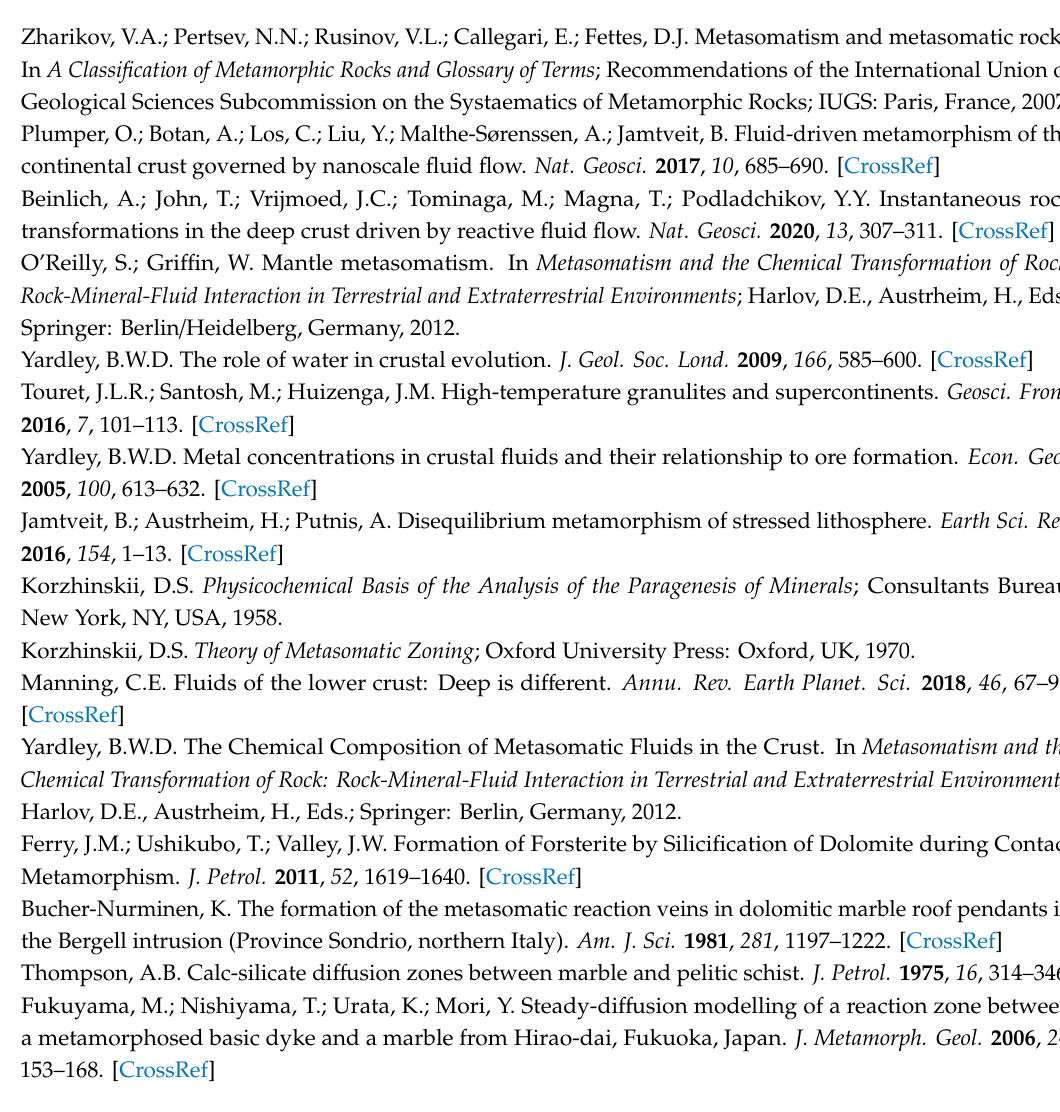
Table S1: Representative EPMA results of biotite, amphibole, plagioclase, ilmenite and apatite in lamprophyre dyke sample; Table S2: Representative EPMA results of olivine, serpentine, biotite, calcite, spinel, hematite and dolomite in the intermediate metasomatized sample; Table S3: Representative EPMA results of serpentine, calcite, dolomite in the marble sample; Table S4: Bulk chemistry results of lamprophyre dyke, intermediate metasomatized zone and dolomitic marble; Table S5: Isocon method using bulk-chemisty data and density of metasomatized and unmetasomatized